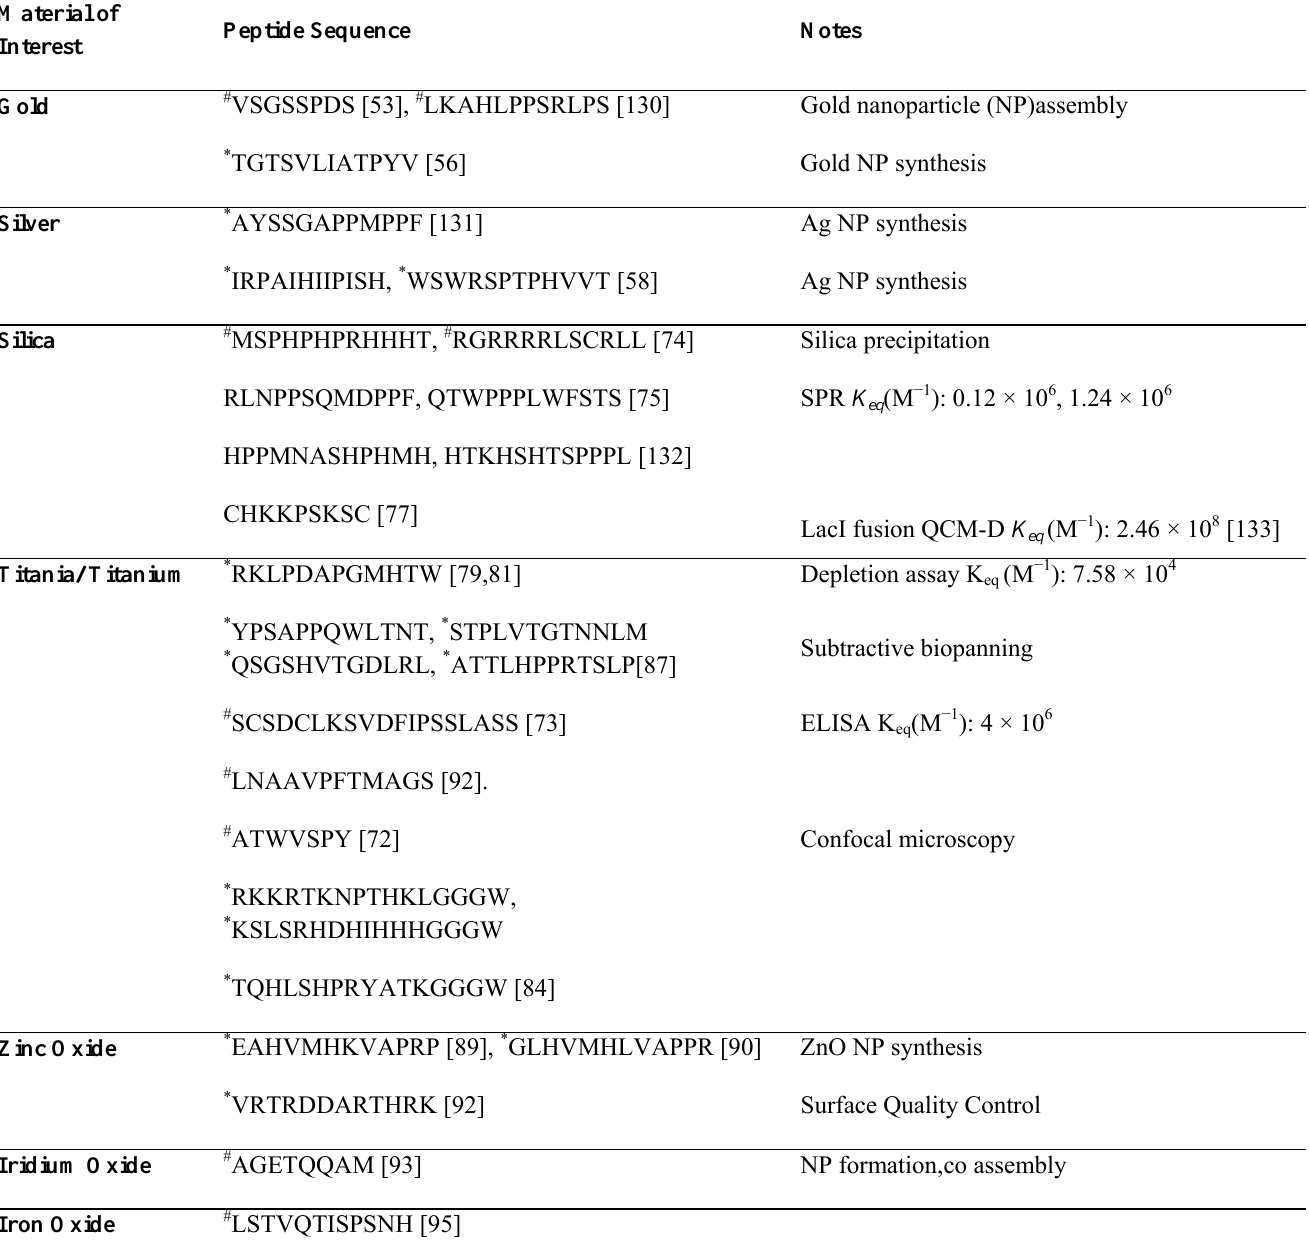
Table 1. Strong Material Binding Peptides from